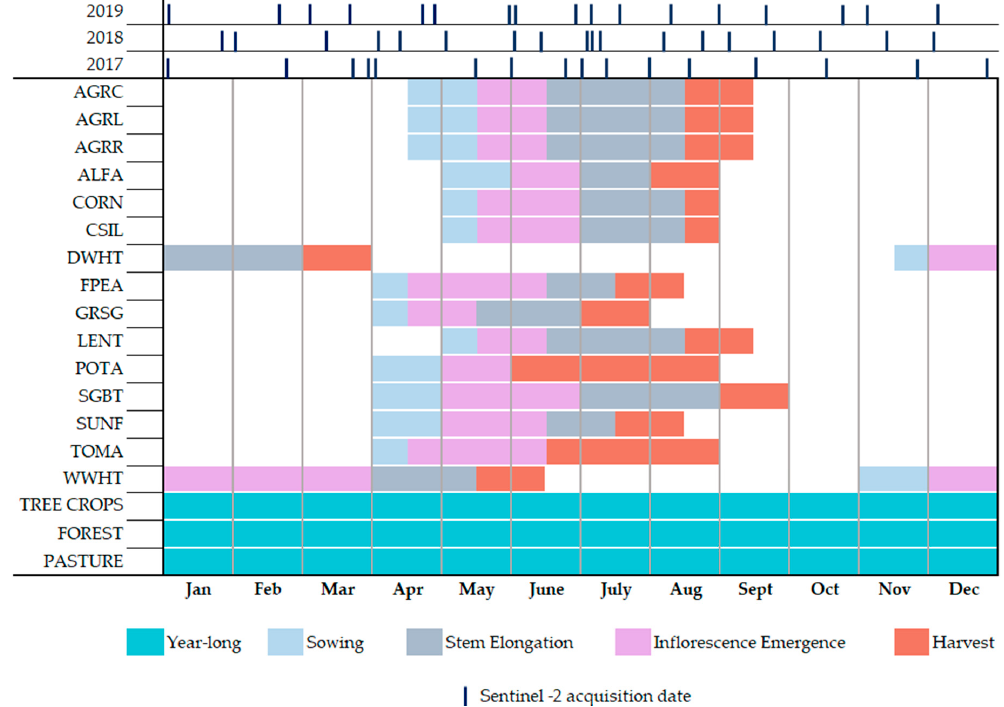
Figure 4. The phenological periods of the classification classes along with lines indicating the temporal coverage of the three sets of Sentinel-2 time series data used in the current study. The abbreviations are presented in Table A1.